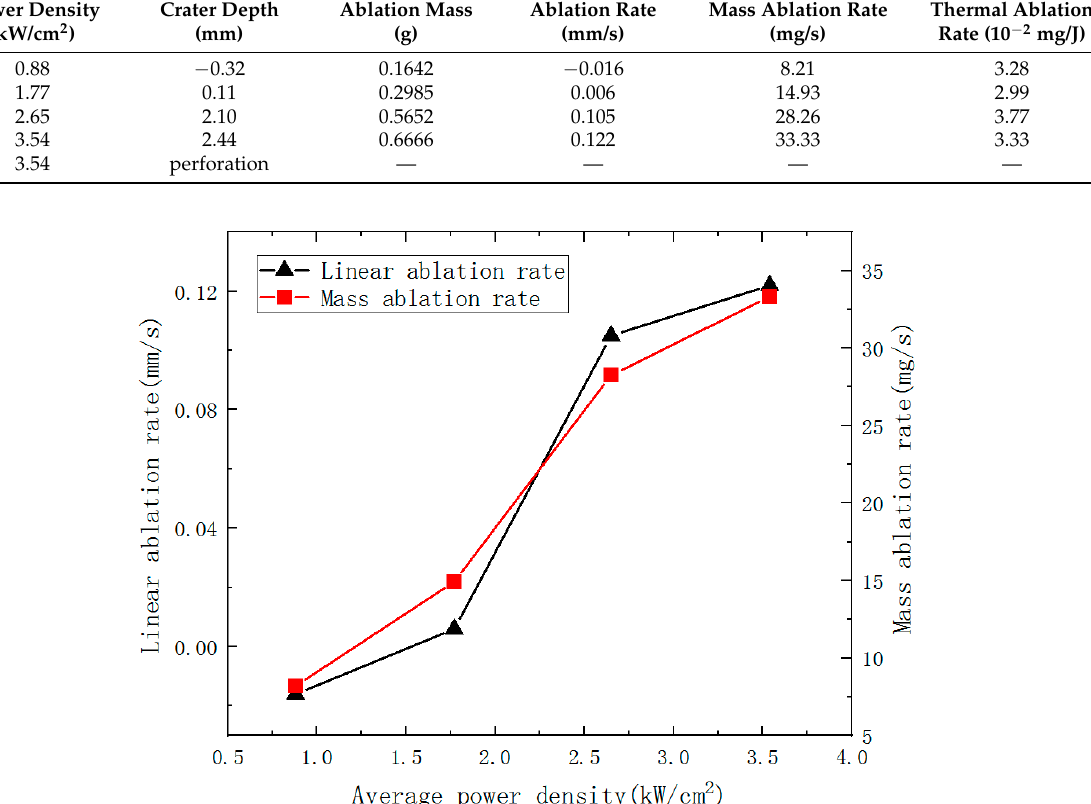
Figure 7. Variation of ablation rate of CFRP laminates with different power density.